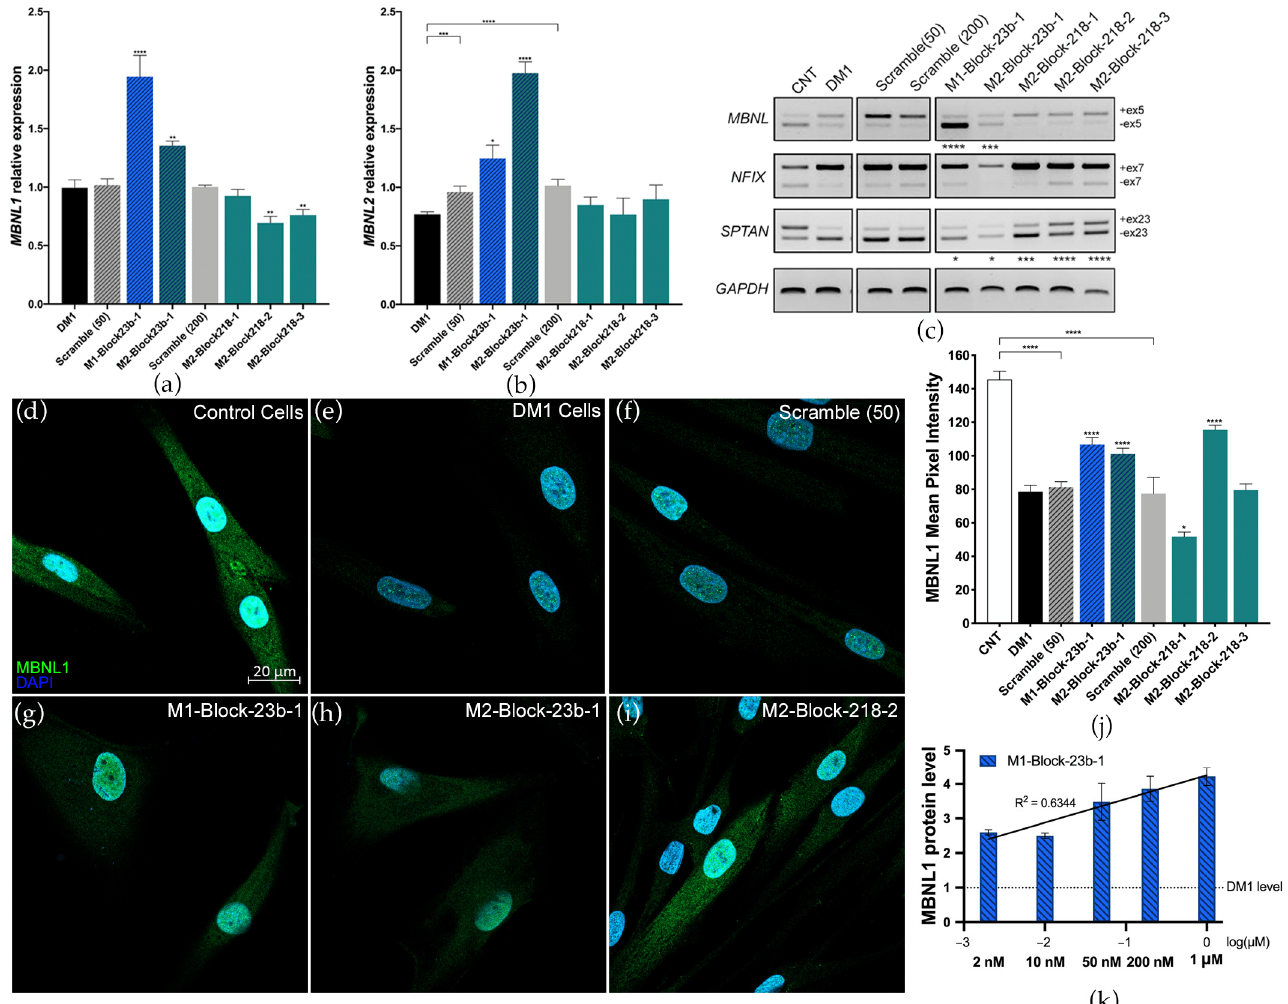
Figure 2. BlockmiRs increase MBNL and improve mis-splicing. Relative expression of ( a ) MBNL1 and ( b ) MBNL2 transcripts after treatment with blockmiRs through RT-qPCR. Data are shown as the average of four technical replicates. GAPDH was used as an endogenous control and MBNL levels were calibrated relative to the respective Scrambles (50 or 200). ( c ) Alternative splicing was analyzed for transcripts MBNL1 , NFIX , and SPTAN1 with GAPDH used as an endogenous control. A representative gel is seen above. Amplicons were generated using three different cDNA replicates and averaged for statistical analysis using Image J. ( d – i ) CNT and DM1 cells were immunostained in parallel for MBNL1 protein (green) and nuclei (DAPI blue). Healthy control cells ( d ) show intense and localized MBNL1 fluorescence in the nucleus and cytoplasm. DM1 cells ( e ) show only punctate fluorescence of MBNL1 in nuclear foci. (Cell count: CNT n = 63; DM1 n = 106; Scramble 50 n = 105; M1-Block-23b-1 n = 86; M2-Block-23b-1 n = 145; M2-Block-218-2 n = 155) ( j ) MBNL1 protein fluorescence was quantified by measuring the mean pixel intensity (Threshold = 10) using Image J normalized by cell area. ( k ) MBNL1 expression in DM1 cells after treatment with M1-Block-23b-1 at increasing concentrations was analyzed using quantitative dot blot (QDB) analysis. All samples were calibrated with GAPDH levels. Data are shown as the average of four technical replicates log-transformed and normalized relative to untreated DM1 cell MBNL1 levels. The black line shows the linear regression with the R 2 value seen above. All samples were compared to their respective Scrambles (50 or 200) via Student’s t -test. p -value: p ≤ 0.05 (*), p ≤ 0.01 (**), p ≤ 0.001 (***), p ≤ 0.0001 (****). Error bars = SEM. Reproduced/adapted from [29] Universitat de Val è ncia, The transcripts MBNL1 , NFIX , and SPTAN1 show abnormal splicing pa tt erns in DM1 cells, which can be seen compared to control cells (CNT) (Figure 2c). Again, blockmiRs M1-Block-23b-1 and M2-Block-23b-1 showed completely reversed inclusion of exon 5 in